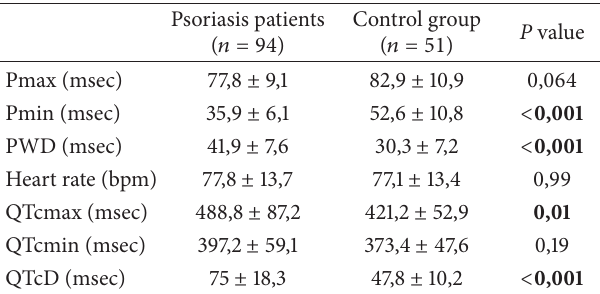
Table 2: Comparison of P wave and QTc parameters and heart rate between psoriasis patients and healthy